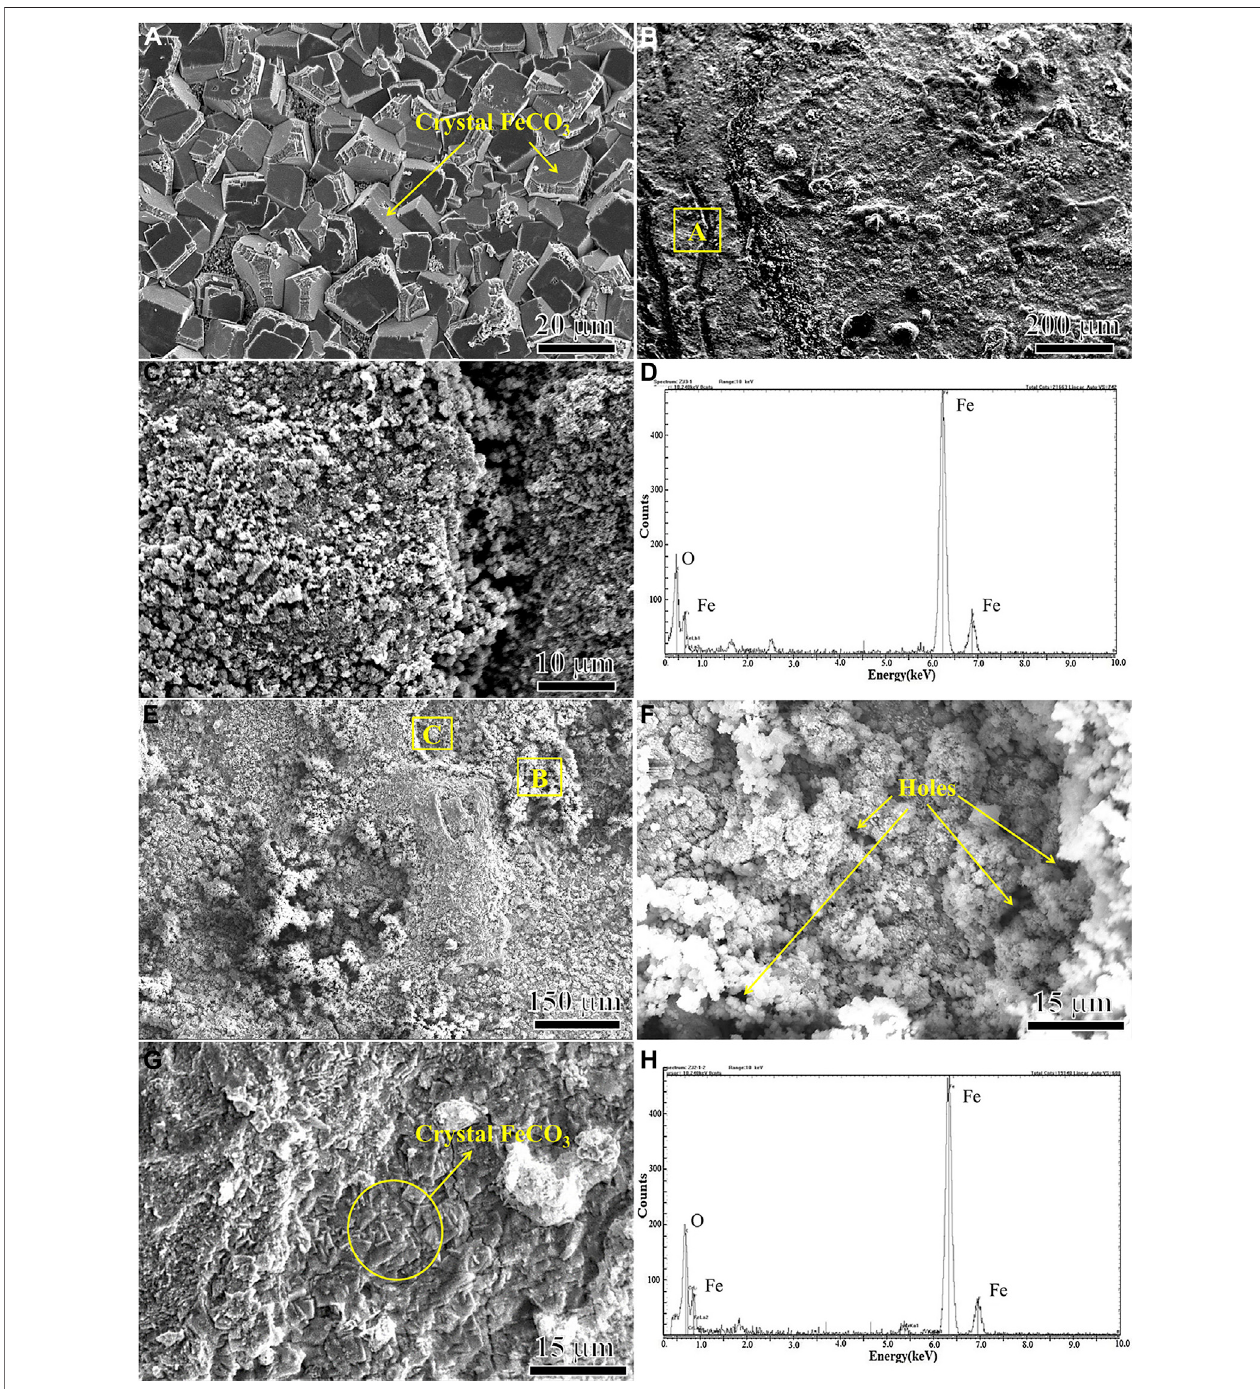
FIGURE7| SEMmicromorphologiesandEDSofoutercorrosionscaleonN80steelunderdifferentexperimentalconditions: (A) CO 2 − 2.5MPa; (B)(C)(D) O 2 − 0.5 MPa; (E) (F) (G) (H) CO 2 − 2.5 MPa, O 2 − 0.5 MPa.